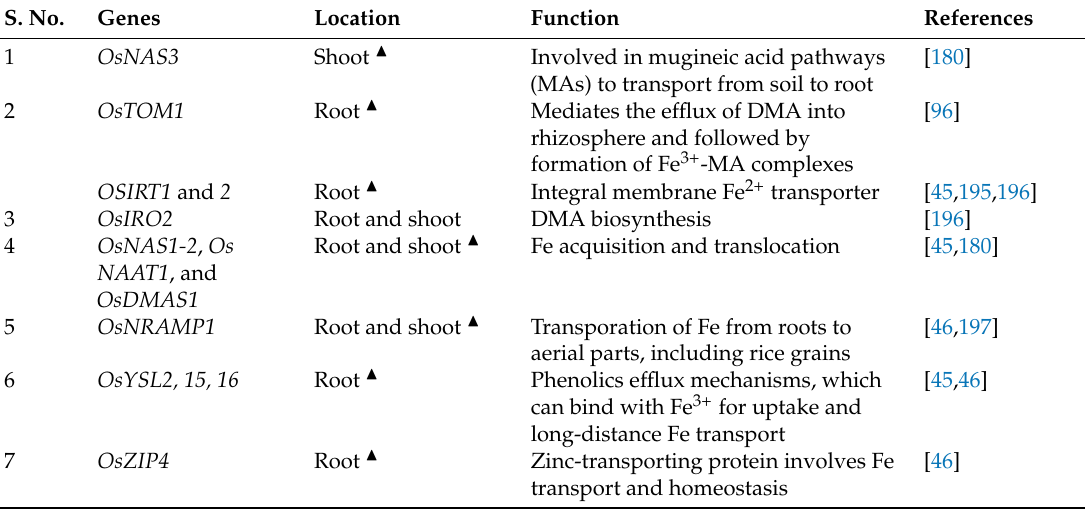
Table 2. List of identified transporters, homeostasis, and translocation of Fe -regulated genes and their putative